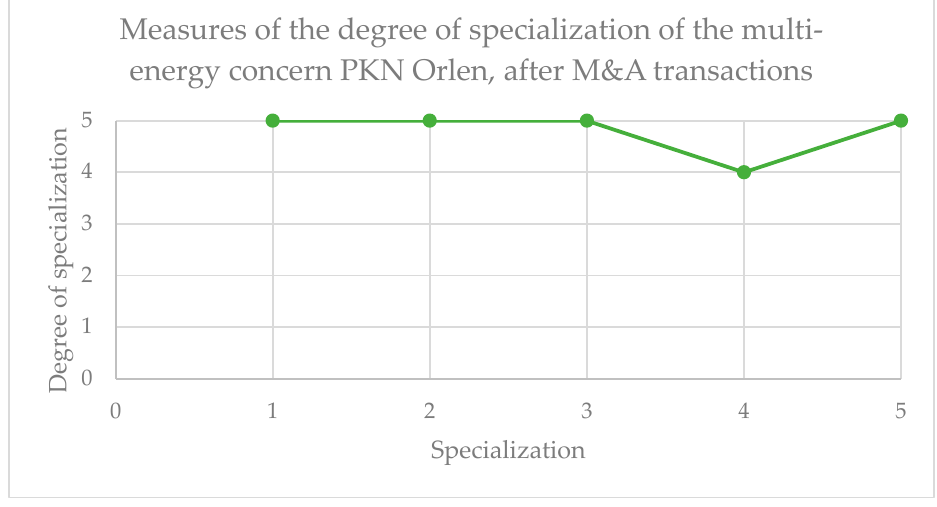
Figure 7. Distribution of the diversification and integration degree of a multi-energy concern after M&A transactions. Explanations for Figure 7: The values in the columns represent the individual specializations of energy companies (before M&A transactions), in accordance with Table 8. The values in the rows represent the degree of these specializations, according to the adopted scale. Source: authors’ own studies.